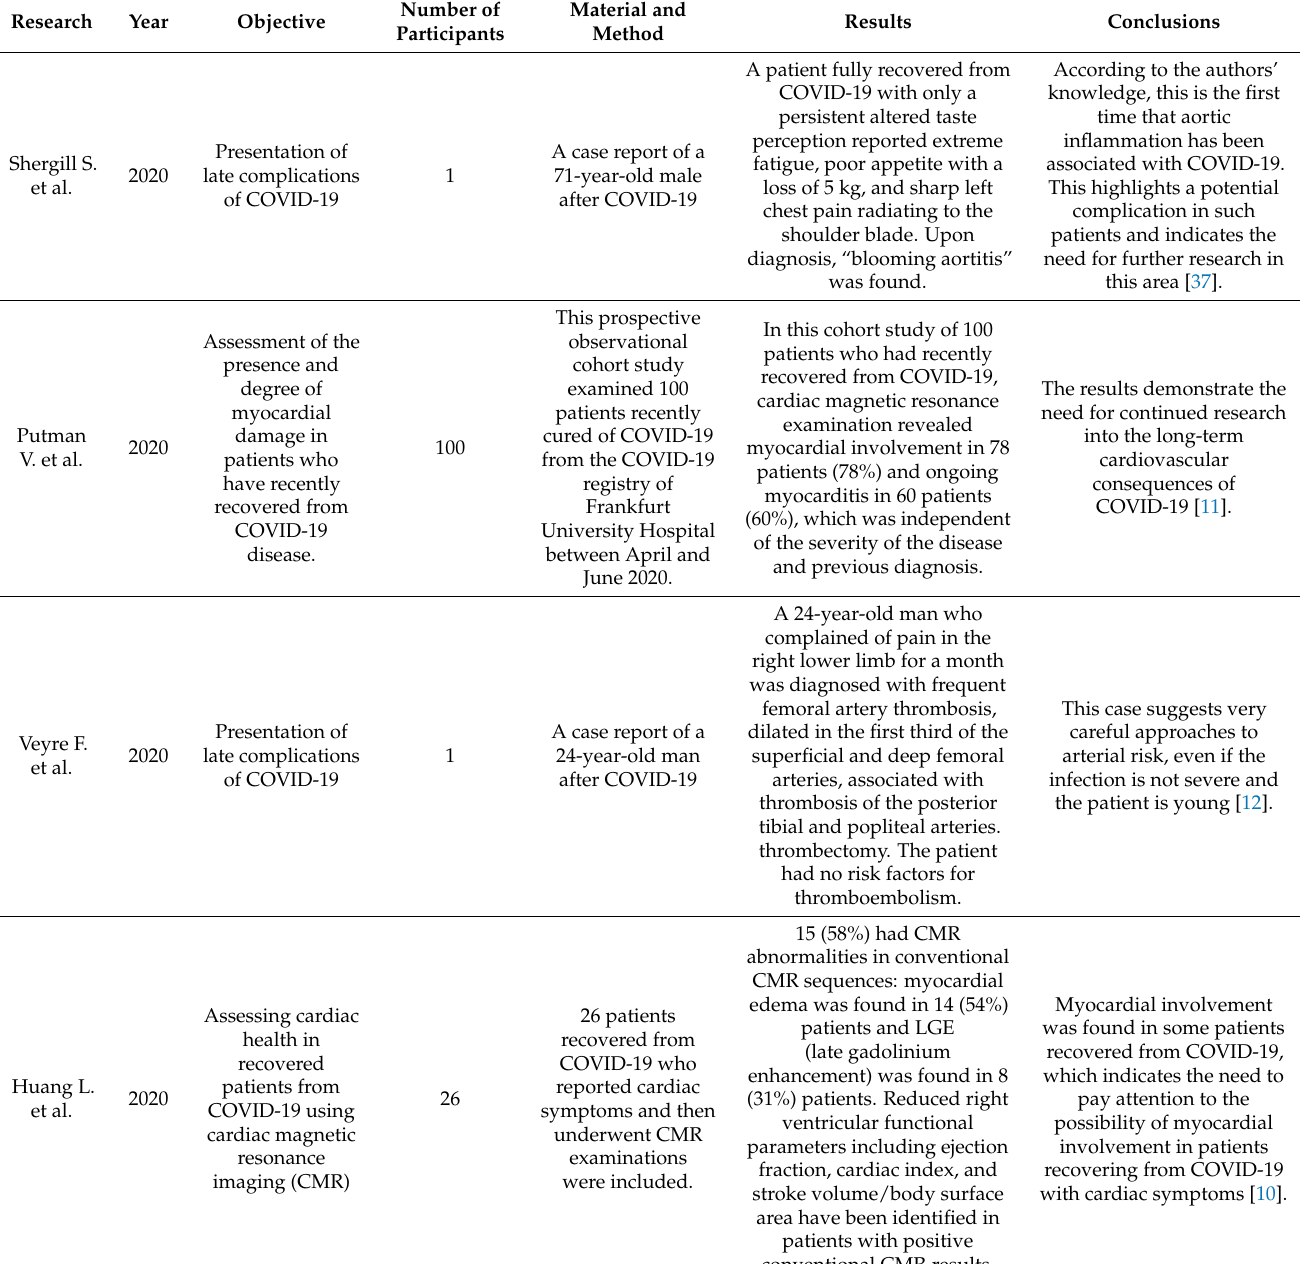
Table 2. The main effects of COVID-19 on the circulatory